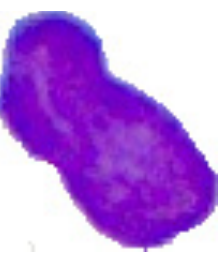
Fig. 11. Distorted